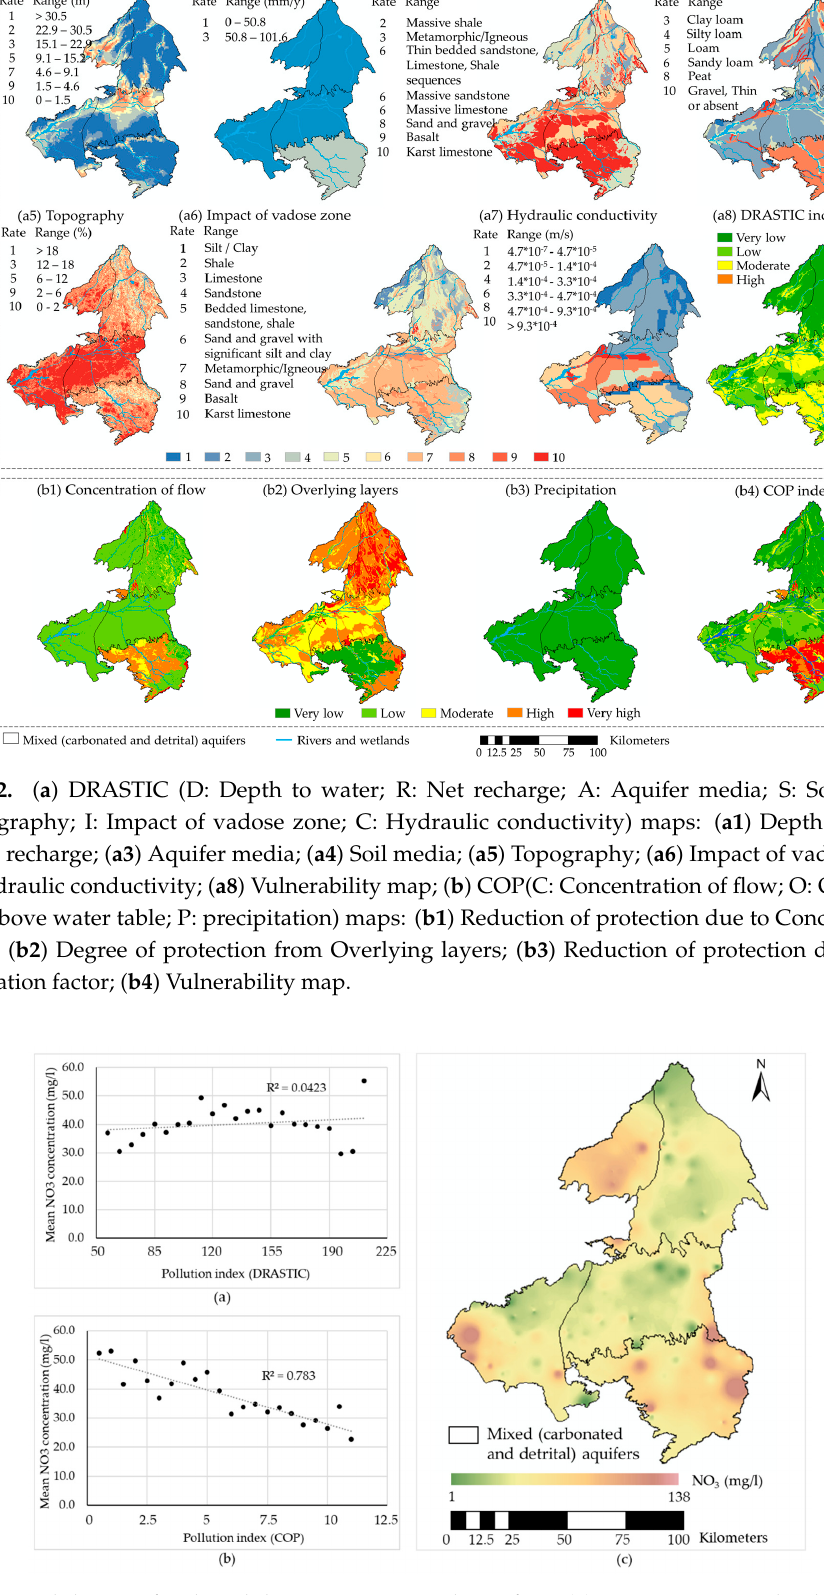
Figure 3. Validation of vulnerability maps in mixed aquifers: ( a ) DRASTIC + 5 × land use (LU); ( b ) COP + 5 / LU; ( c ) mean nitrate concentration map (1975–2015).